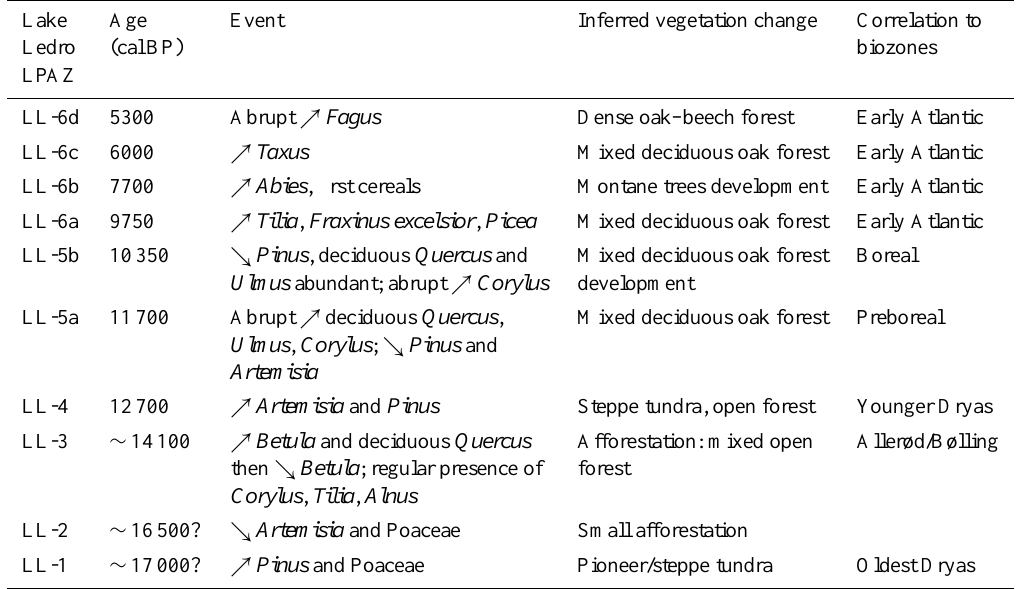
Table 3. Local pollen zones as established in Fig. 4a and b with indication of floristic composition, inferred vegetation change and correlation to biozones.